Question: Provide a publication-style caption for this figure.
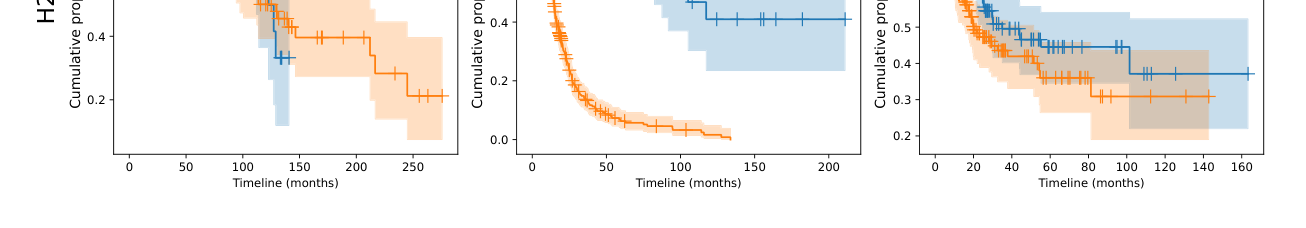
Answer: Kaplan-Meier Analysis on three datasets, where patient stratifications of low risk (blue) and high risk (orange) are presented. Shaded areas refer to the confidence intervals. P-value < 0.05 means a significant statistical difference in two groups, and a lower P-value is better.